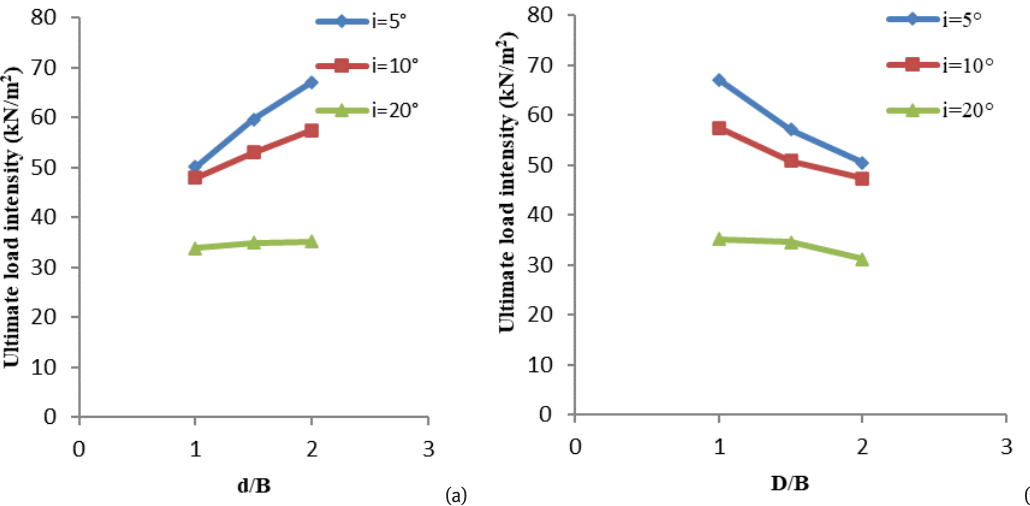
Figure 8: Variation of ultimate load intensity with normalized (a) depth of confiner at D/B = 1.0 (b) top surface dimension of confiner at d/B = 2.0 for footing with confiner